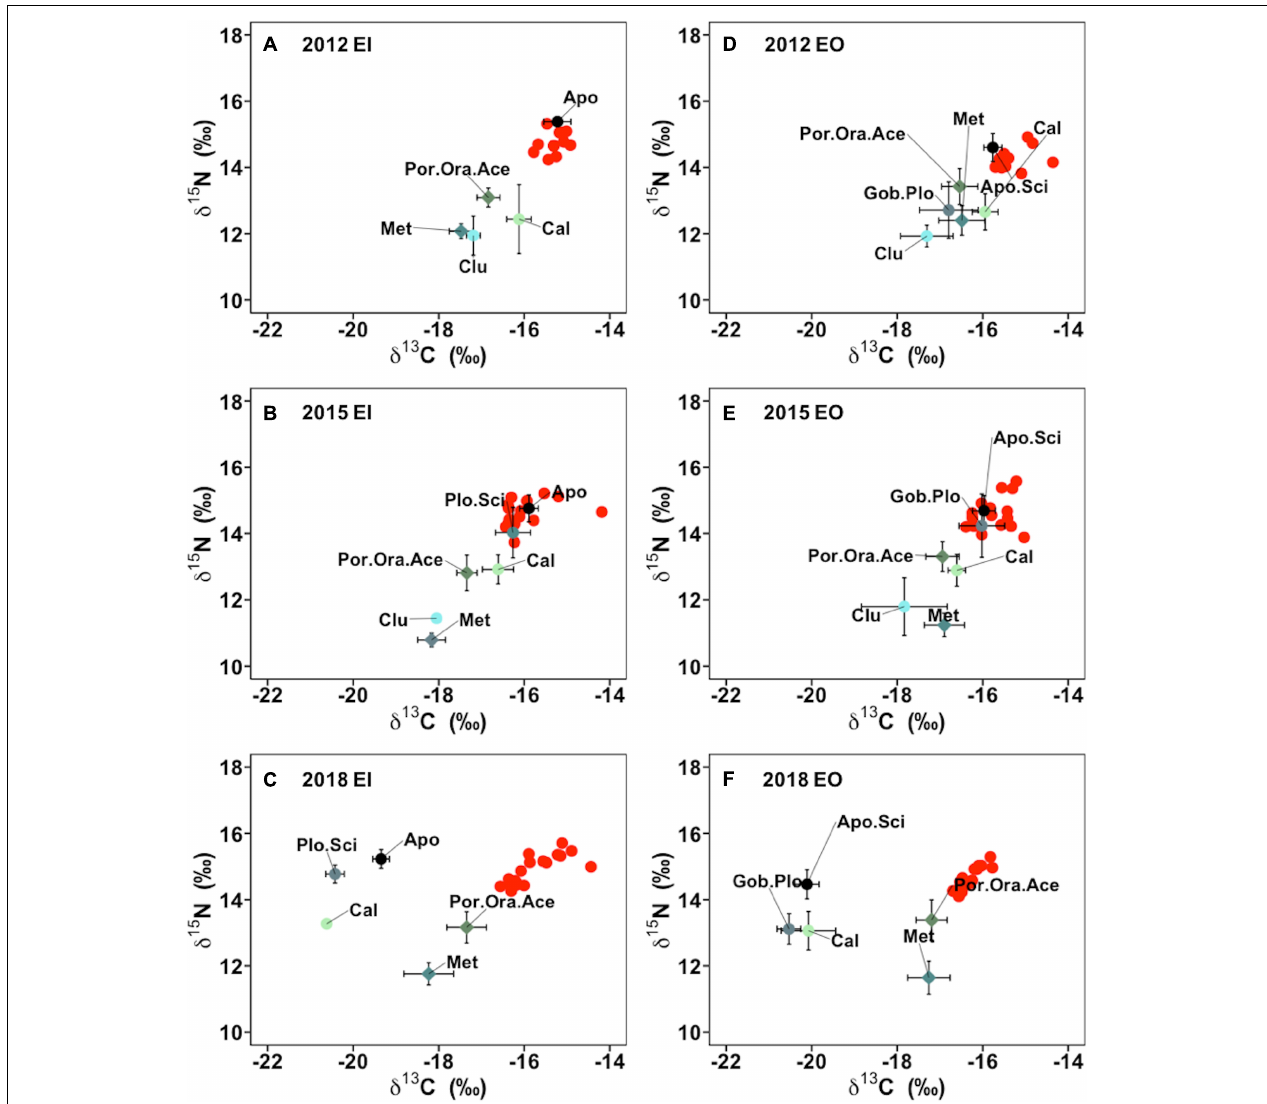
FIGURE 5 | Isotope signatures of δ 13 C and of δ 15 N of Platycephalus indicus (red dots) and its potential food source (mean ± SEM) collected in inner Tolo Channel (EI) (A–C) and outer Tolo (EO) (D–F) from dry season of 2012, 2015, and 2018. Grouped species abbreviations in EI and EO: Apo, species from family Apogonidae; Apo.Sci, species from family Apogonidae and Sciaenidae; Cal, species from family Callionymidae; Clu, species from family Clupeidae; Gob.Plo, species from family Gobiidae and Plotosidae; Met, Metapenaeopsis sp.; Plo.Sci, species from family Plotosidae and Sciaenidae; Por.Ora.Ace, including species of Portunus dayawanensis , Portunus pseudohastatoides , Oratosquilla oratoria , and Acetes species.